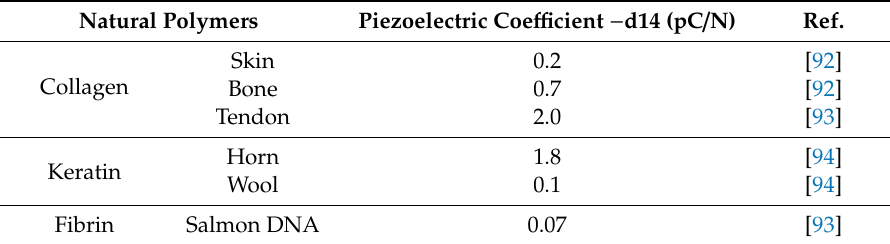
Table 1. Natural polymers with the piezoelectric response.